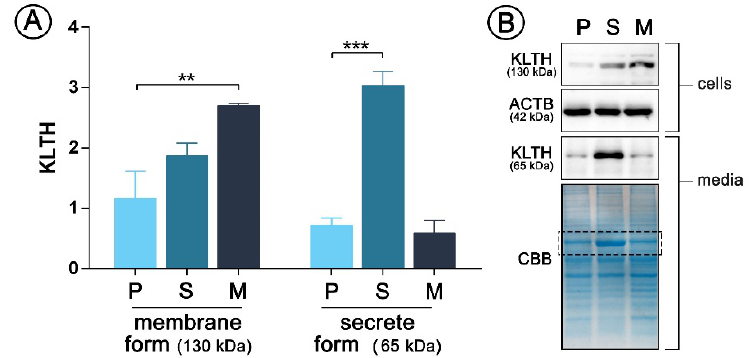
Figure 1. pDNA(plasmid DNA)-mediated klotho overexpression in human monocytic cells Cells were transfected with pDNA and selected in antibiotics to obtain stable clones and then Western Blot analysis of klotho membrane (130 kDa) and secrete (65 kDa) forms expression was performed ( A ). Representative images of Western Blot membrane and Coomassie staining are presented ( B ). The bands were quantified and normalized to their corresponding β -actin bands in the case of membrane form of klotho or to CBB staining in the case of secrete form. Bars indicate SD, n = 3, *** p < 0.001, ** p < 0.01 (one-way ANOVA and Dunnett’s a posteriori test). ACTB actin, KLTH klotho, CBB Coomassie Brilliant Blue staining.